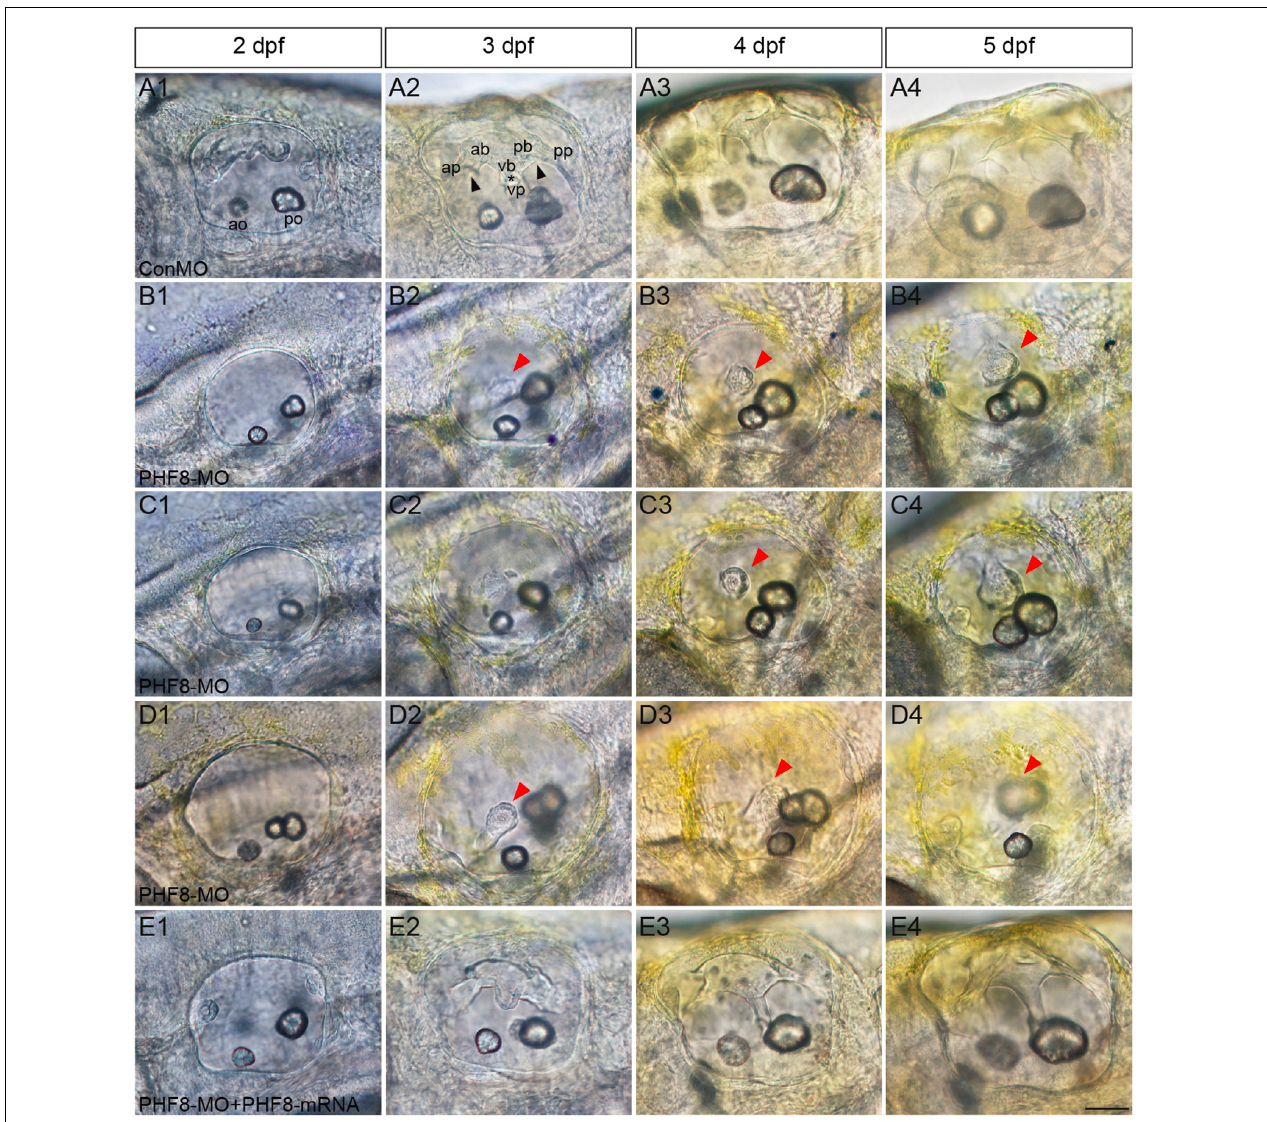
FIGURE 7 | Analysis of semicircular canal formation in PHF8 morphant. (A–E) The overall morphology of semicircular canal in control embryos (ConMO; A ), PHF8 morphants (PHF8-MO; B–D ), and PHF8-MO co-injected with PHF8-mRNA embryos (PHF8-MO + PHF8-mRNA; E ) at 2 dpf (A1–E1) , 3 dpf (A2–E2) , 4 dpf (A3–E3) , and 5 dpf (A4–E4) . Black arrowheads indicate the junction of the anterior protrusion (ap) and the anterior bulge (ab) and the junction of the posterior bulge (pb) and posterior protrusion (pp). Asterisks point out the junction between the ventral bulge (vb) and ventral protrusion (vp). Red arrowheads mark disrupted projections. The locations of the anterior otolith (ao) and posterior otolith (po) are implied. All pictures are lateral views with the anterior to the left and the dorsal side up. Scale bar, 50 µ